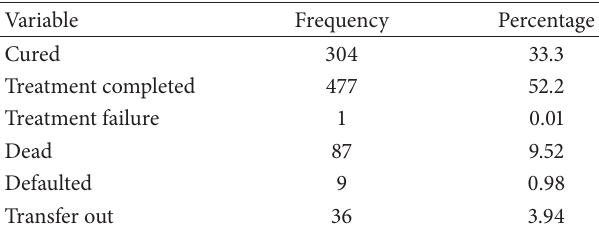
Table 3: Overall outcome of patients with tuberculosis treatment in Ogbomoso, Oyo State.